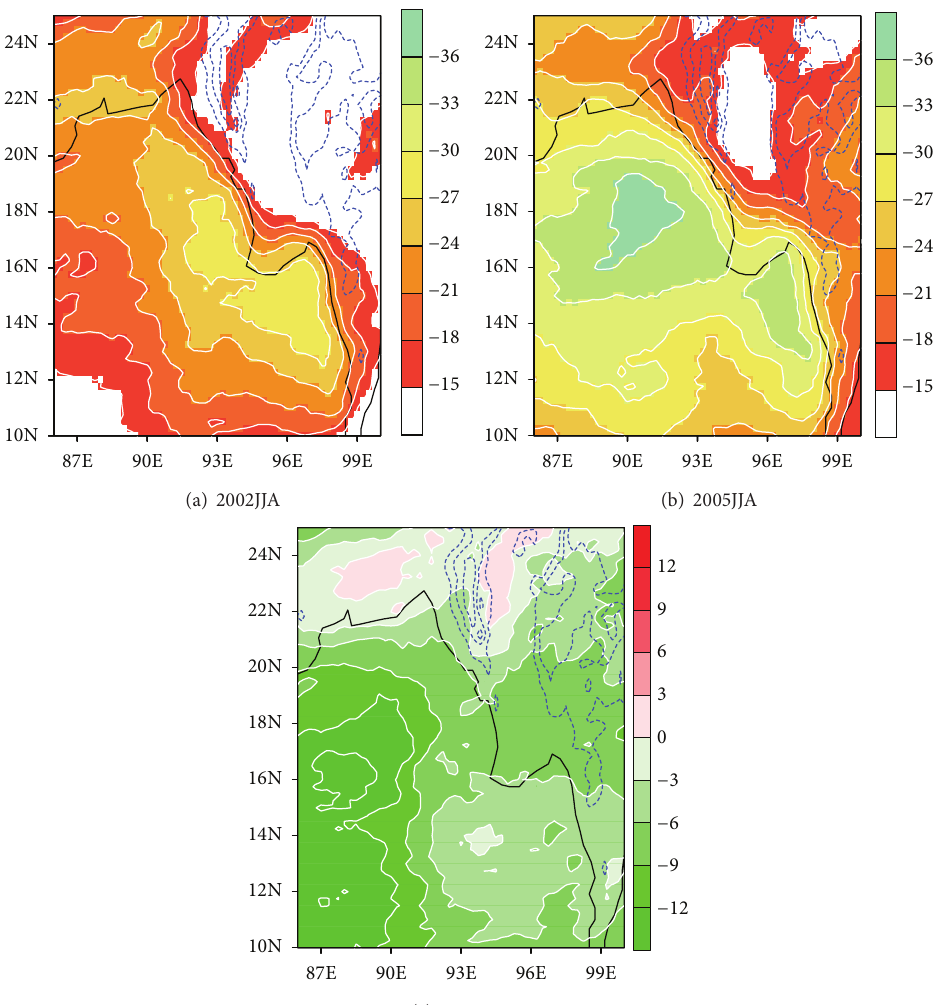
Figure 5: JJA mean black body temperature (Tbb in ∘ C) distribution in 2002 (a), 2005 (b), and their difference (c). The purple dotted contours are the topography at 500 m, 1000m, and 1500 m above sea